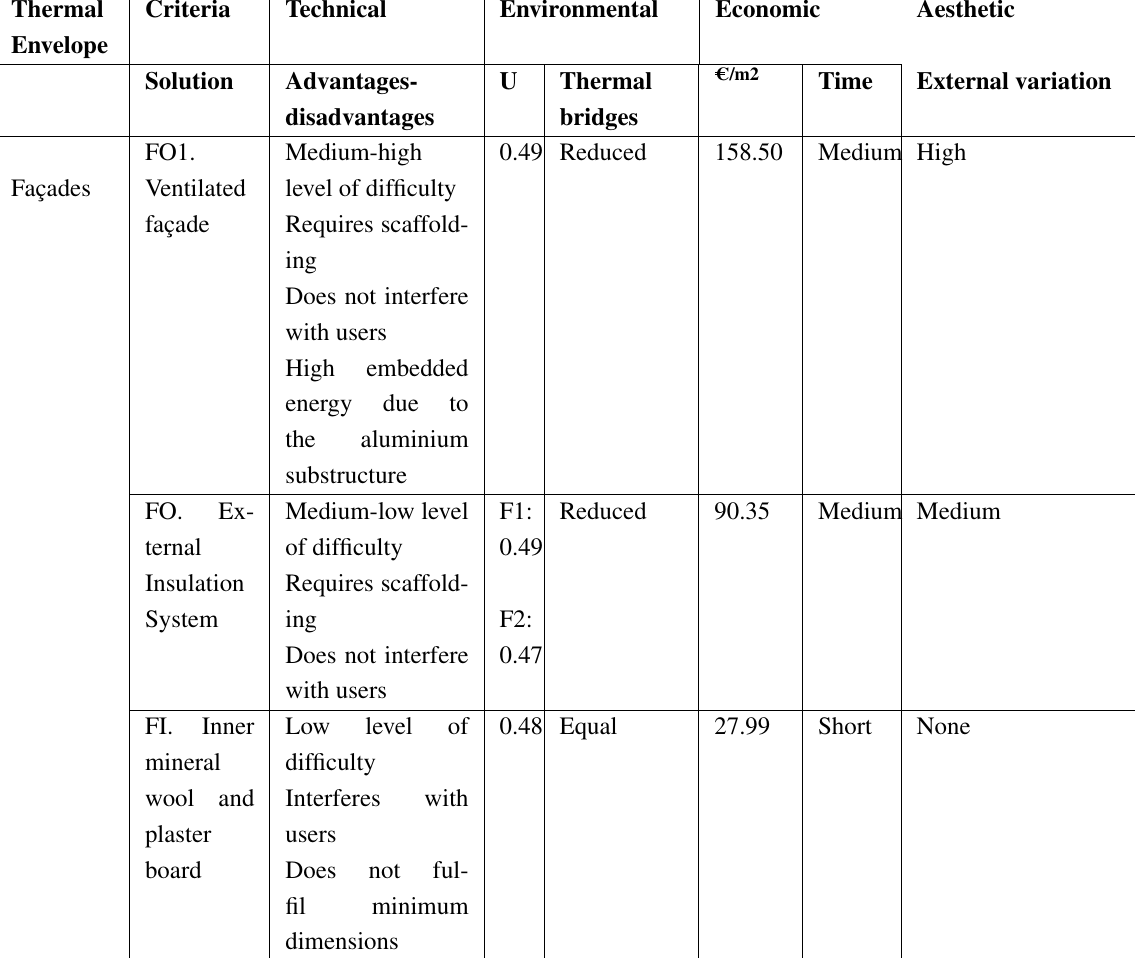
Table 3. Multicriteria analysis of the constructive solutions for the thermal